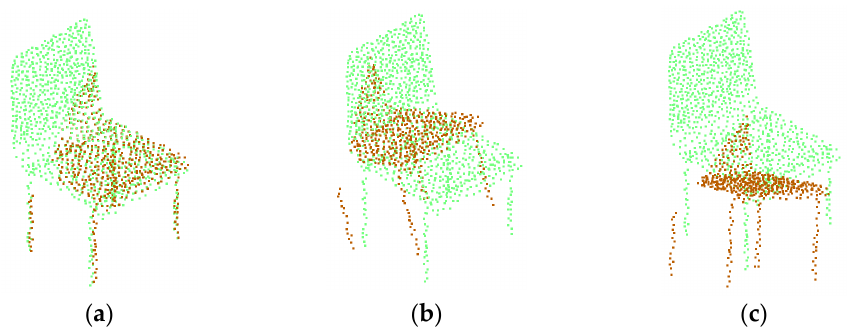
Figure 10. Effect of registration: ( a ) TMPE-Net R Δ = 3.7°, t Δ = 0.029; ( b ) PRNet R Δ = 17.5°, t Δ = 0.269; ( c ) RPM-Net R Δ = 21.7°, t Δ = 0.328.